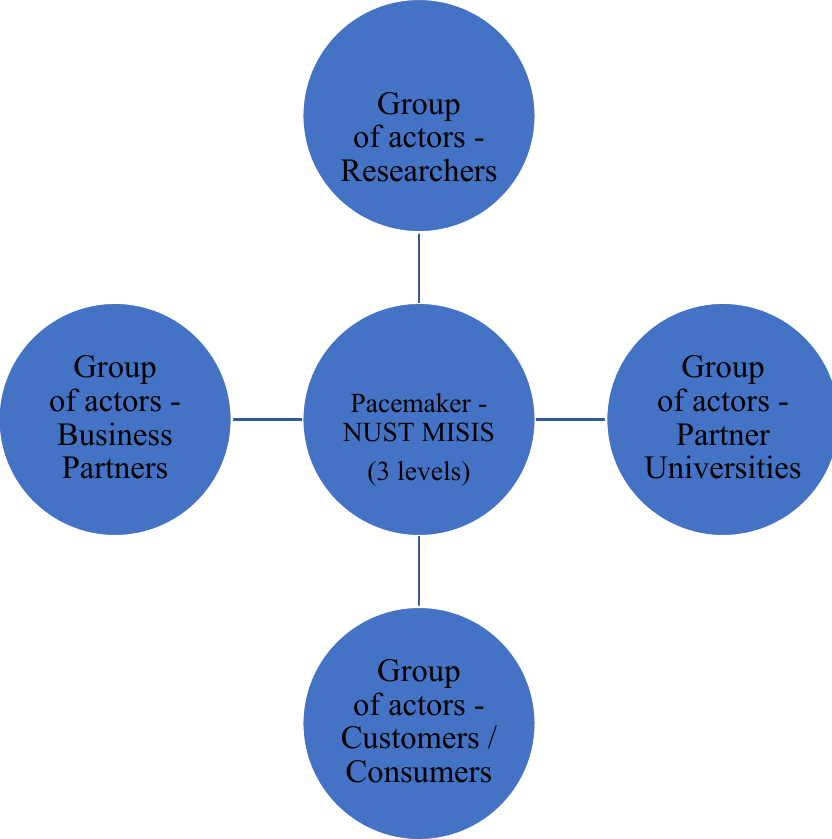
Figure 3. The structure of the ecosystem “Green technologies for resource